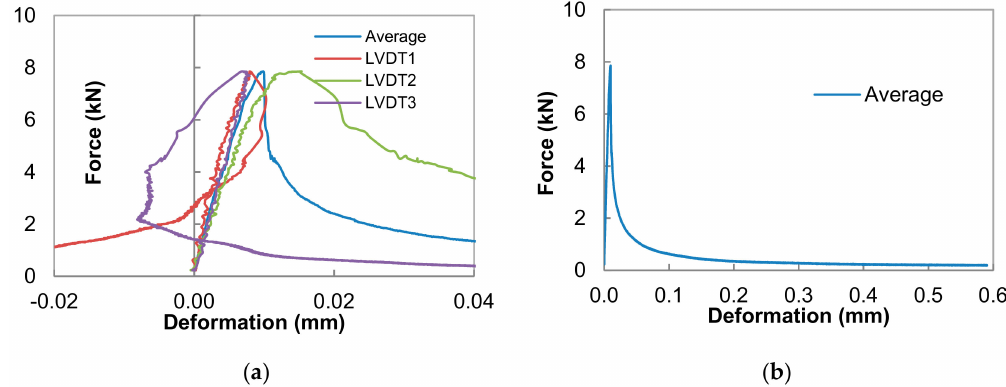
Figure 4. Overview of force-deformation curves for a specimen with finer aggregate at an age of 5 days. ( a ) The initial part of deformation-force curve for each LVDT; ( b ) the average deformation-force curves.